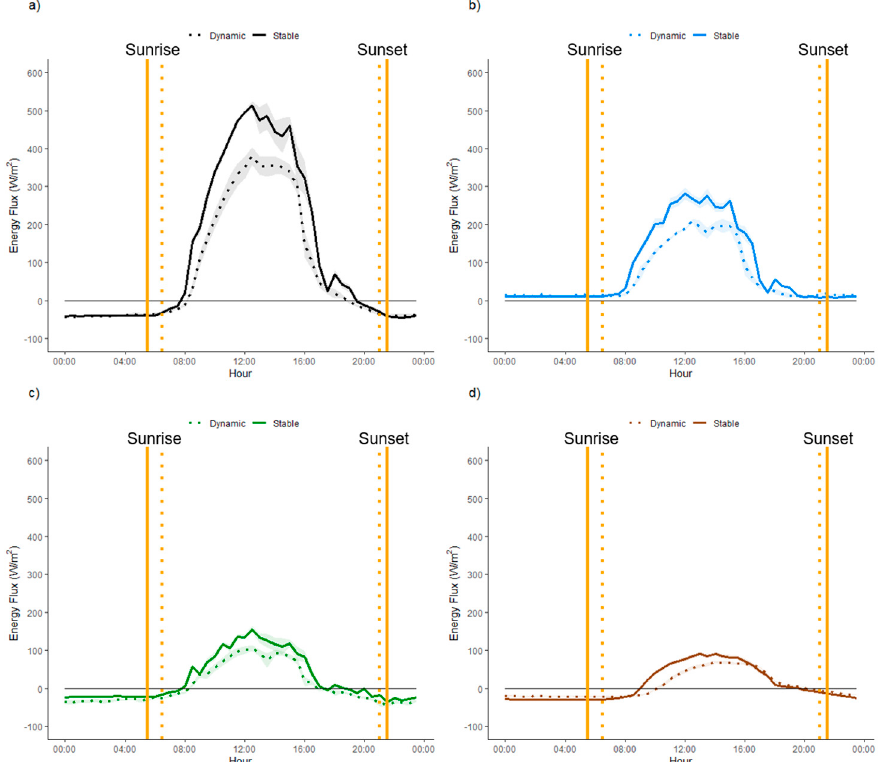
Figure 10. Diurnal Peak Growing Season energy budget contributions defined by ( a ) net radiation (Q*), ( b ) latent heat flux (Q e ), ( c ) sensible heat flux (Q h ) and ( d ) ground heat flux (Q g ) for Stable Shade (21 July to 30 July) and Dynamic Shade (31 July to 23 August). 95% confidence intervals are shaded around each diurnal flux, while the average sunrise and sunset for Stable Shade (solid) and Dynamic Shade (dashed) are also listed.